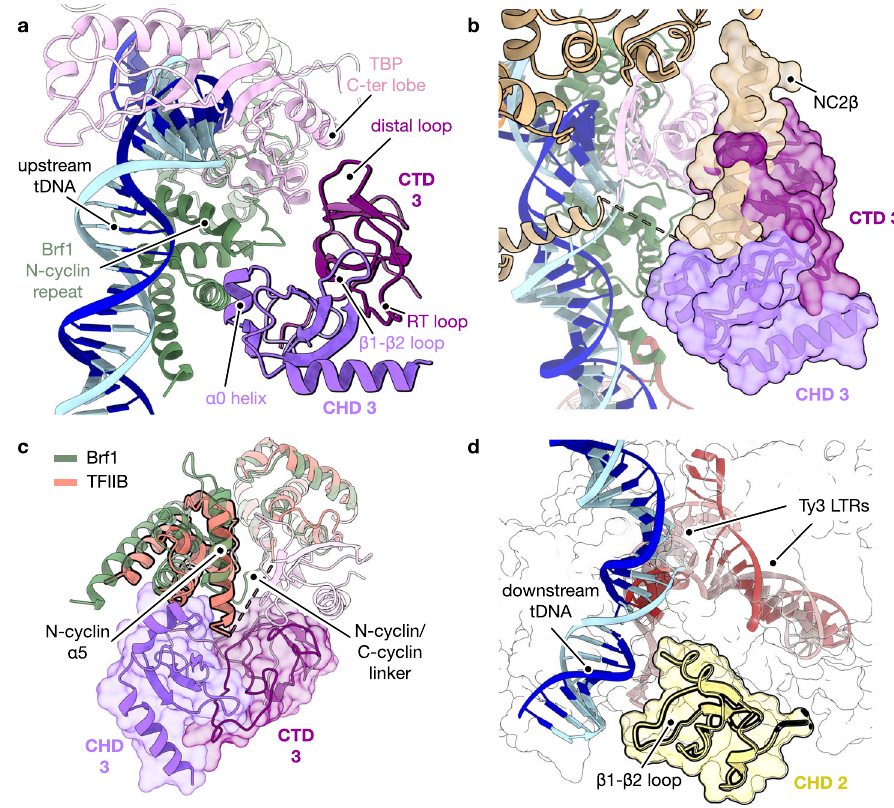
Fig. 4 Architecture of TFIIIB – Ty3 interaction and molecular basis of integration speci fi city. a Detail of TFIIIB transcription factor and Ty3 integrase binding domains, represented as ribbon models. The distal loop of Ty3 integrase C-terminal domain (CTD 3, purple) interacts with TBP C-terminal lobe (pink) whereas Ty3 integrase vestigial chromodomain (CHD 3, violet purple) is recruited to Brf1 N-terminal cyclin repeat (green) through its helix 0 ( α 0). CTD 3 and CHD 3 domains associate through the RT loop and the β 1 – β 2 loop, respectively, adopting a novel tandem small β -barrel conformation. b Binding of the transcription regulator negative cofactor 2 (NC2 β , wheat surface, PDB code: 4WZS) and Ty3 intasome to TBP C-terminal lobe requires the same interface, which compromises the recruitment of Ty3 retrotransposon (purple, molecular surface) to RNA Pol II transcriptional units. Structural models are superimposed on TBP molecule (pink ribbon). c The B-core cyclin repeat architecture of TFIIB (orange) and Brf1 (green) transcription factors differs in the length of the N-cyclin helix 5 ( α 5) and the N/C cyclin linker, which prevents binding of Ty3 intasome (purple, molecular surface) to TFIIB and integration at RNA Pol II-transcribed genes. d The vestigial chromodomain of a symmetrically related Ty3 integrase subunit (CHD 2, yellow) establishes contacts with the target DNA (tDNA) downstream of Ty3 LTRs integration